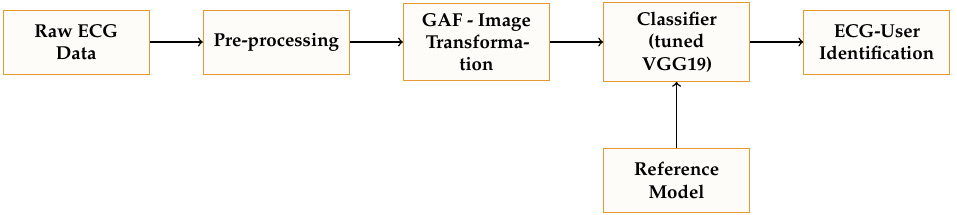
Figure 4. An ECG GAF-based identification system: general